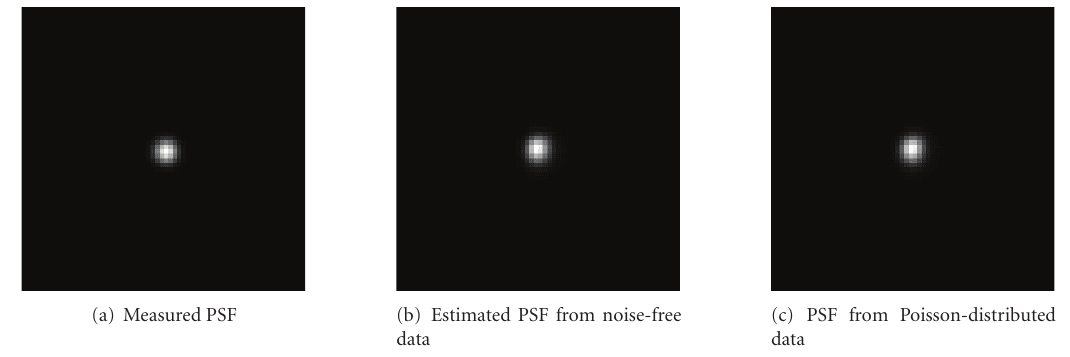
Figure 3: Estimated point spread function (PSF) for blind deblurring